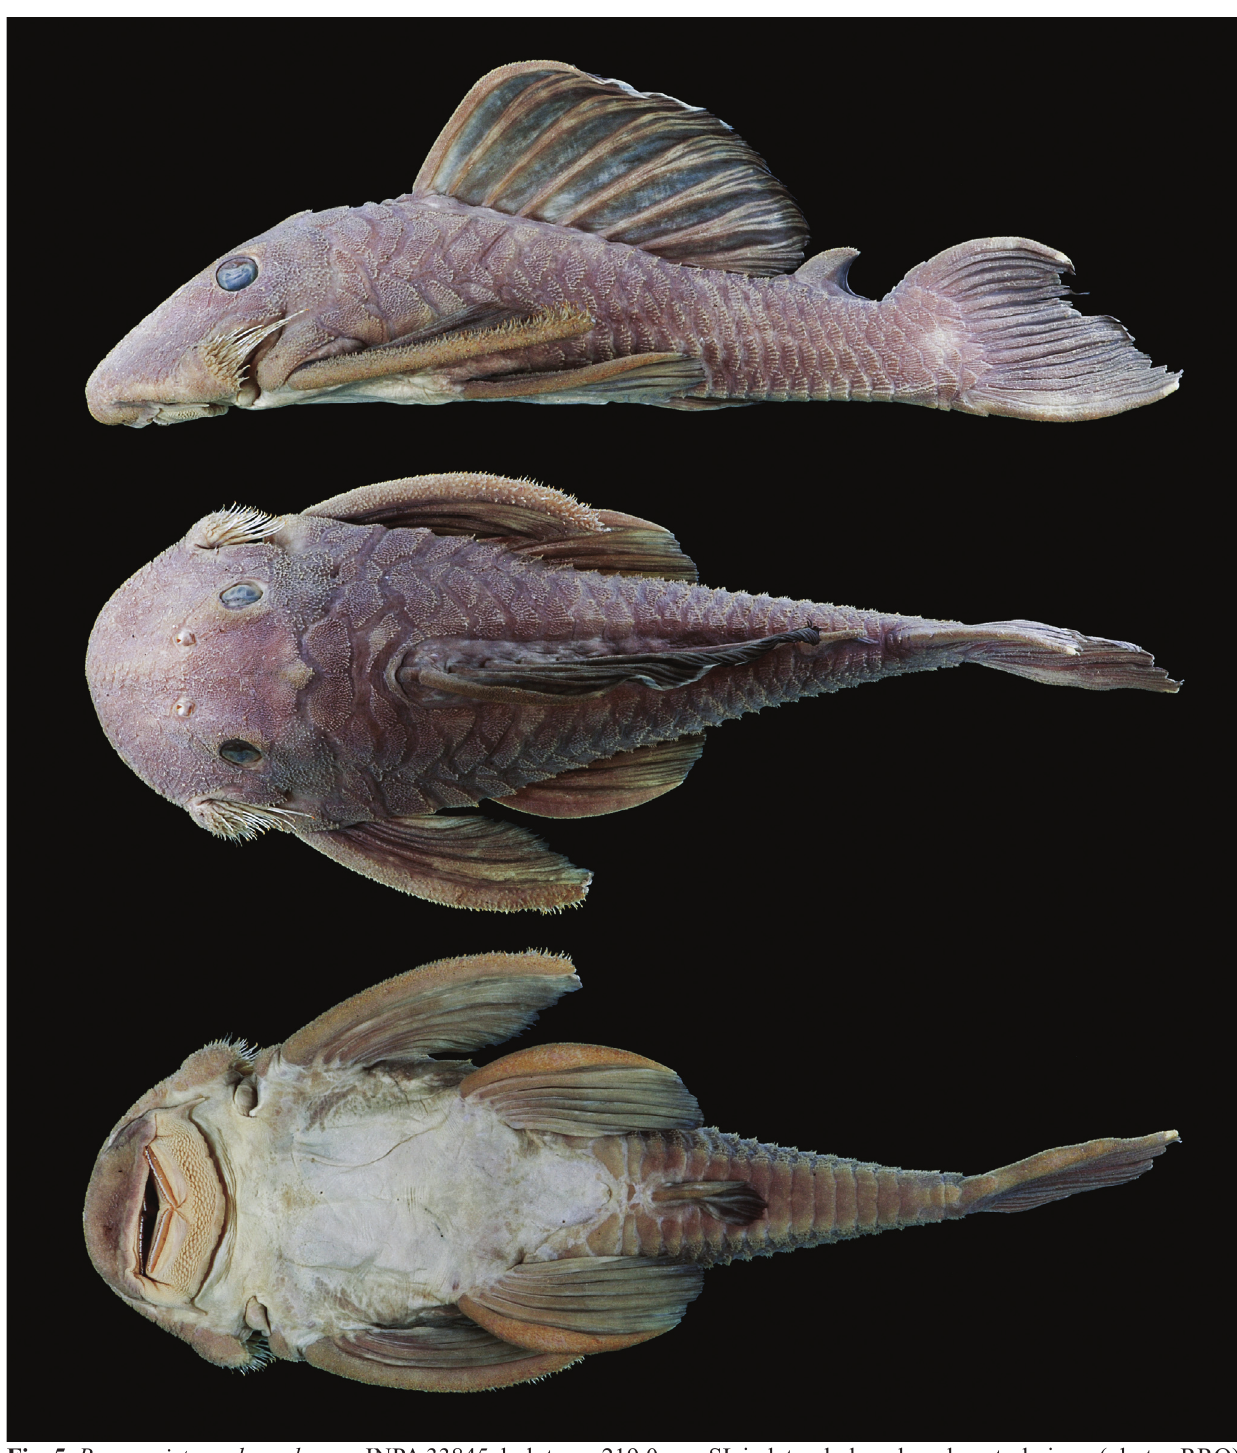
Fig. 5. Baryancistrus chrysolomus , INPA 33845, holotype, 219.0 mm SL in lateral, dorsal, and ventral views (photos RRO). Brazil, Pará, Altamira, rio Xingu at Furo do